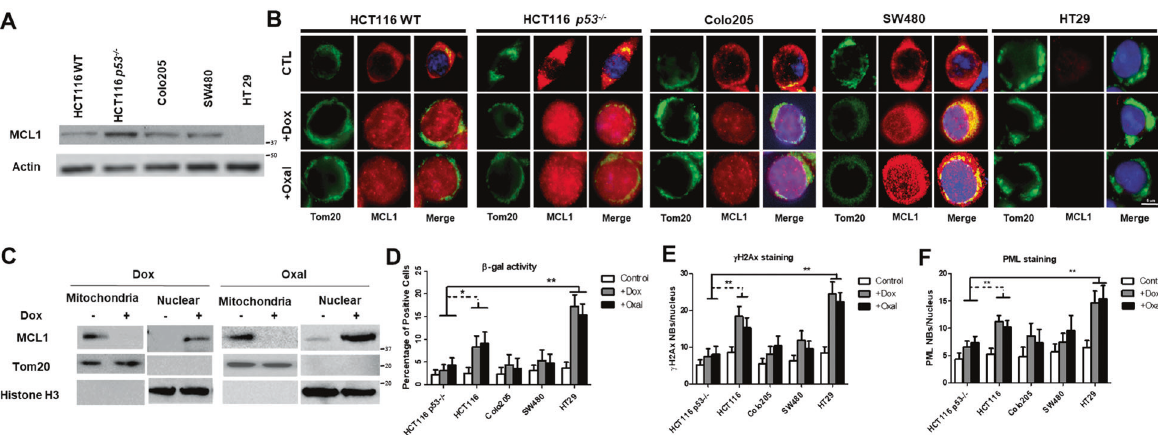
Fig. 1 MCL1 protein nuclear translocation can be induced by chemotherapy treatment. A Western blot for MCL1 protein level in CRC cell lines HCT116 wild type (WT), HCT116 p53 − / − , Colo205, SW480, and HT29. Actin was used as loading controls. Data are representative of three independent experiments. B Representation of confocal microscopy images of CRC cell lines: HCT116 WT, HCT116 p53 − / − Colo205, SW480, and HT29 treated with doxorubicin (100 ng/ml) (middle panel) and oxaliplatin (10 μ M) and no drug treatment control (top panel). Cells were stained with anti-Tom20 (Green) and anti-MCL1 (Red) antibodies. Nucleus were stained with DAPI (Blue). C Mitochondria extraction and nuclear extraction were isolated from HCT116 p53 − / − cells treated with doxorubicin (100 ng/ml) (left panel) or oxaliplatin (10 μ M) (right panel). No drug treatment was used as control. Western blot was used to detect the protein level of MCL1. Tom 20 was used as an indicator of mitochondria and Histone H3 was used as an indicator of the nucleus. Data are representative of two independent experiments. Quantitative analysis of chemotherapy-induced senescence (CIS) in CRC cell lines and analyzed for β -gal activities ( D ), γ H2AX nuclear bodies formation ( E ), and PML nuclear bodies formation ( F ). T-test is used to calculate the p -value, *, p < 0.05 and **, p < 0.01 for the indicated doxorubicin or oxaliplatin treated cell line compared with HCT116 p53 − / − cells. Error bars represent + / −